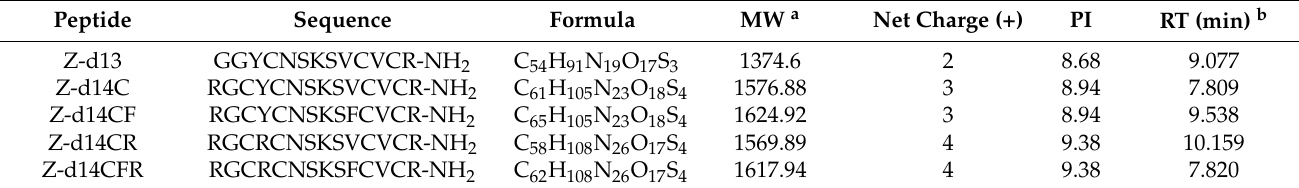
Table 1. Peptide